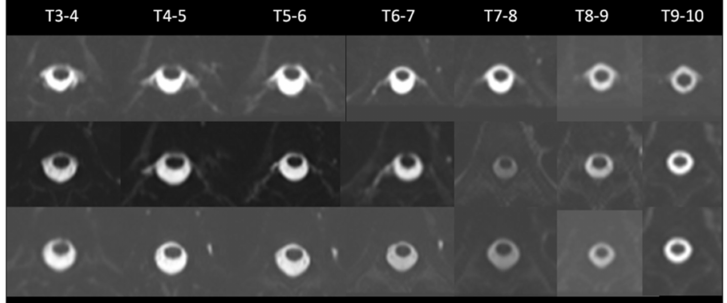
Figure 3. A 39-year-old male with SIH. ( Upper row ) Initially, MR myelography revealed CSF leakage in the bilateral T3-4, T4-5, T5-6, T6-7, T7-8, T8-9, and T9-10 neural sleeves. (no. of spinal CSF leakage = 14). ( Middle row ) Post-EBP MR myelography performed five days after EBP revealed CSF leakage at the right T4-5, T5-6, and T6-7 neural sleeves. (no. of spinal CSF leakage = 3). ( Lower row ) Three-month MR myelography revealed complete resolution of CSF leakage. (no. of spinal CSF leakage =